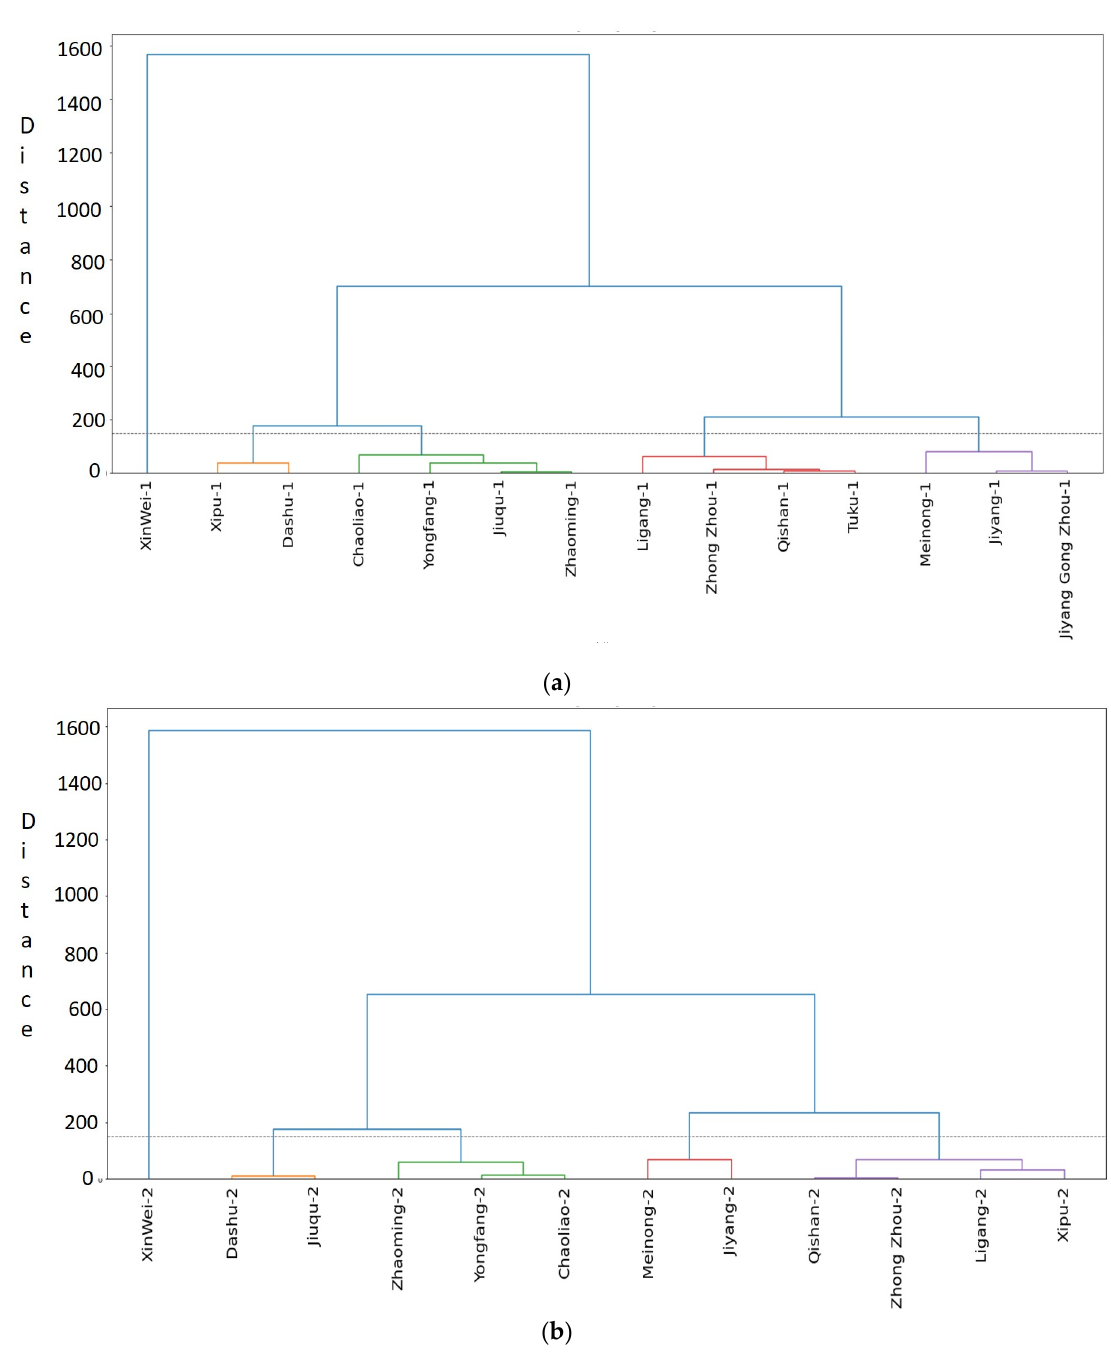
Figure 6. The dendrogram of hierarchical clustering analysis. ( a ) Aquifer 1 ( b ) Aquifer 2. According to the characteristics of sedimentation affecting hydrogeological conditions, the gravel layer with higher hydraulic conductivity at the top of the alluvial fan is often thicker. As the downstream of the stream, fine-grained sediments increase, the characteris- tics of the groundwater changes in the estuary are gradually different, and this is reflected in the cluster analysis. In Figure 7, from the top of the alluvial fan along the altitude slope along the Kaoping River, it is naturally classified as Group 5: XinWei; Group 4: Meinong, Ji Yang, Ji Yang-G; Group 3: Qi Shan, Zhong Zhou, Tu Kou, Li Gang; Group 2: Xi Pu, Da Shu; Group 1: Jiu Qu, Yong Fang, Chao Liao, Zhao Ming. The results of aquifer 2 are similar to those of aquifer 1, except that Xi Pu is classified as Cluster 3 and Jiu Qu is classified as Cluster